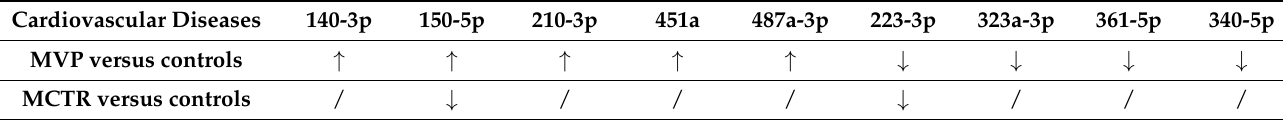
Table 2. Concordant results from Bulent et al. [19] and Songia et al. [53]. Patients affected by MTCR were found to have lower levels of miRNA 150-5p with respect to controls while miR-223-3p in MVP and MTCR groups was found to be lower than controls. (Slashes indicate that some results of miRNA testing on MCTR were not available). MVP: mitral valve prolapse, MCTR: mitral chordae tendineae